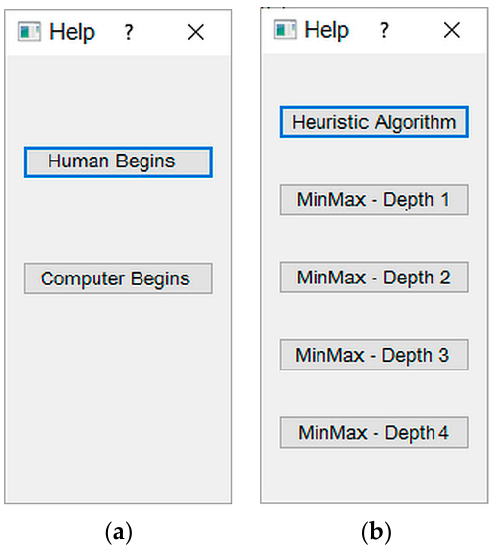
Figure 6. The introduction window ( a ) and the algorithm-selection window( b ) of the GUI.